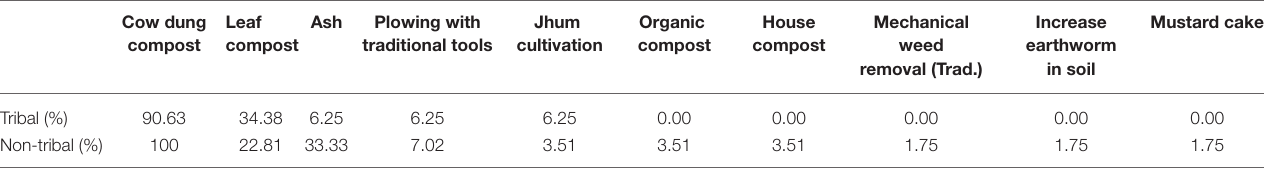
TABLE 5 | Farmer assessment of traditional practices to increase soil fertility (farmer-identified).